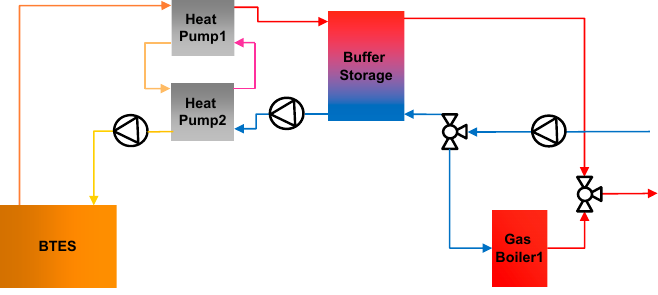
Figure 5. System layout of parallel heating scenarios.